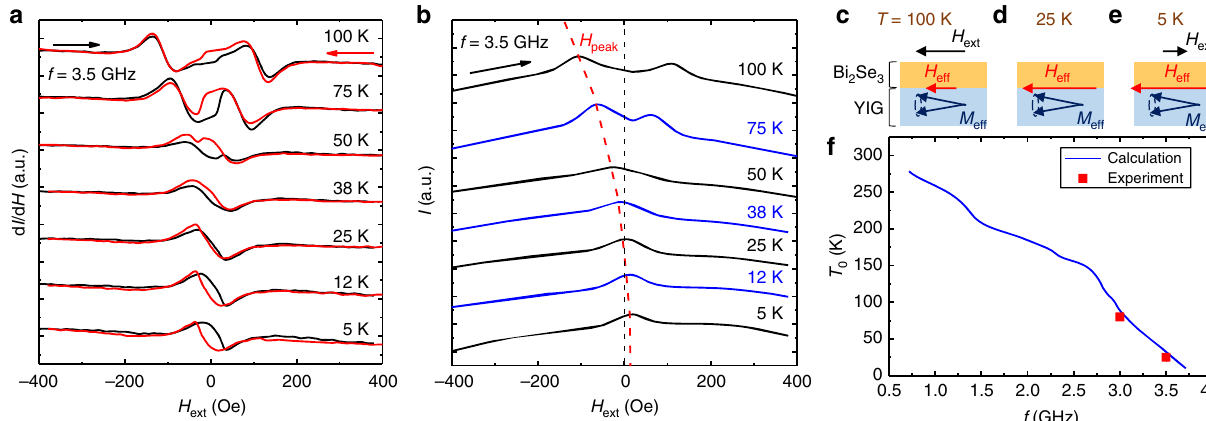
Fig. 4 Zero- fi eld FMR of the Bi 2 Se 3 (25)/YIG(15) sample. a , b FMR fi rst derivative and microwave absorption spectra for various T , respectively. The arrows indicate the H ext sweep direction. The dashed line in b traces the T evolution of the absorption peak H peak . c , d , and e Schematics of the Bi 2 Se 3 /YIG sample when T = 100, 25, and 5 K, respectively. f Zero- fi eld FMR temperature T 0 as a function of